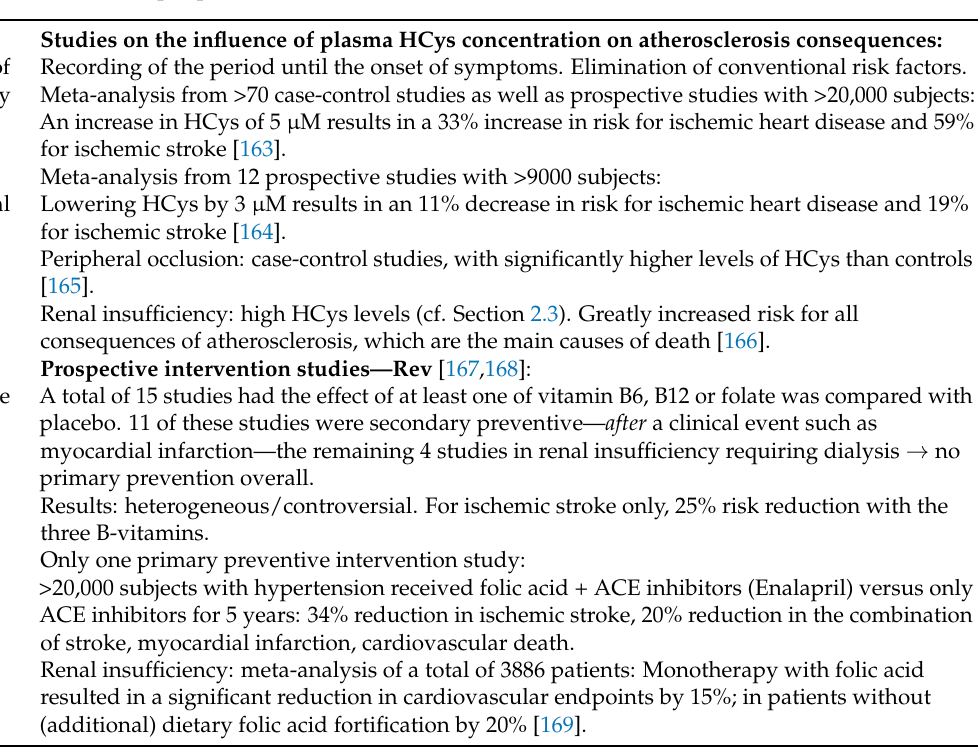
Table A1. Atherosclerosis and its consequences: cardiac ischemia, peripheral occlusion, cerebral ischemia.